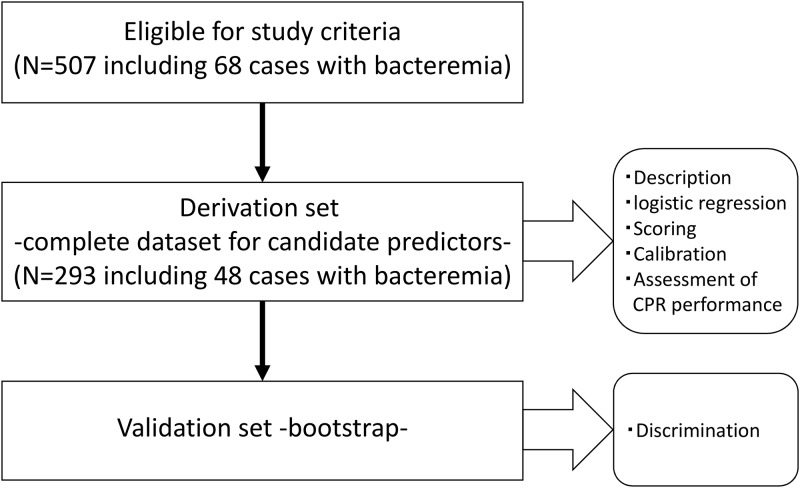
Study flow CPR: clinical prediction rule.